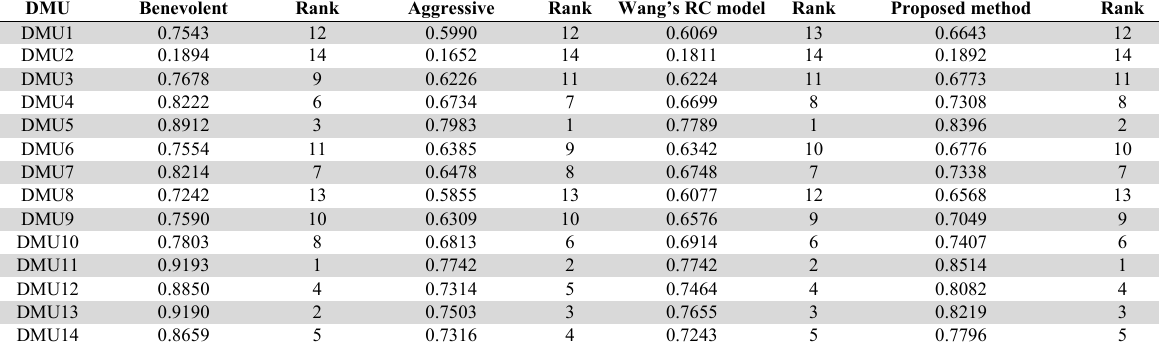
After obtaining the combined CEM, DMU s ratings ( w i ) were obtained, and all DMUs were ranked as listed in Table 24. Finally, Spearman’s rank correlation was used for testing the correlation ( r s ). The details of each r s value are shown in Table 25. The rating and ranking comparison for fourteen international passenger airlines DMU Benevolent Rank